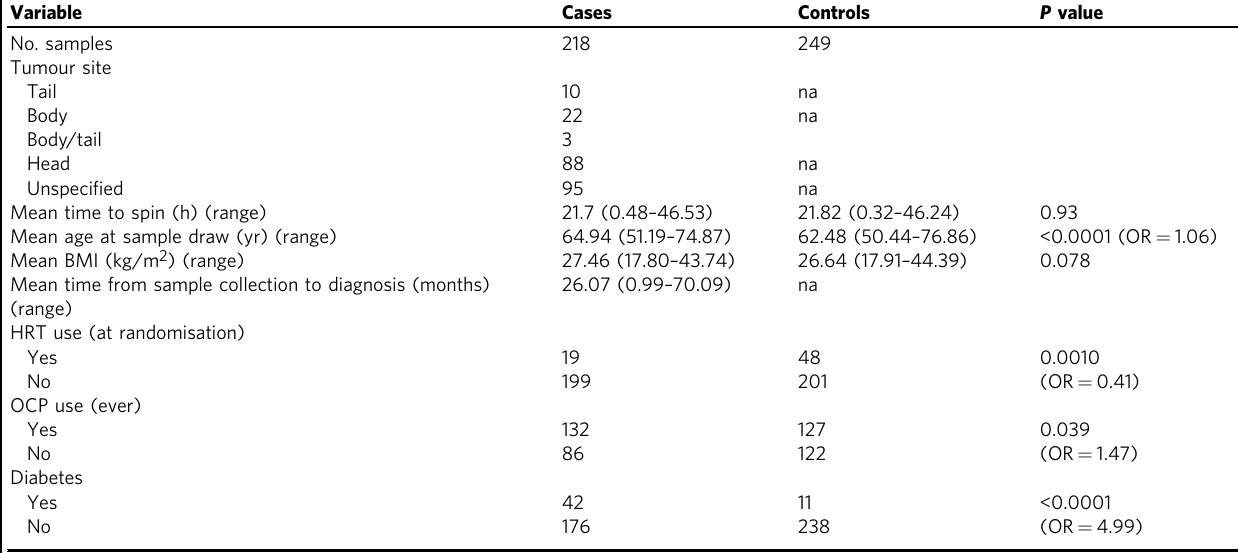
Table 1 Study dataset